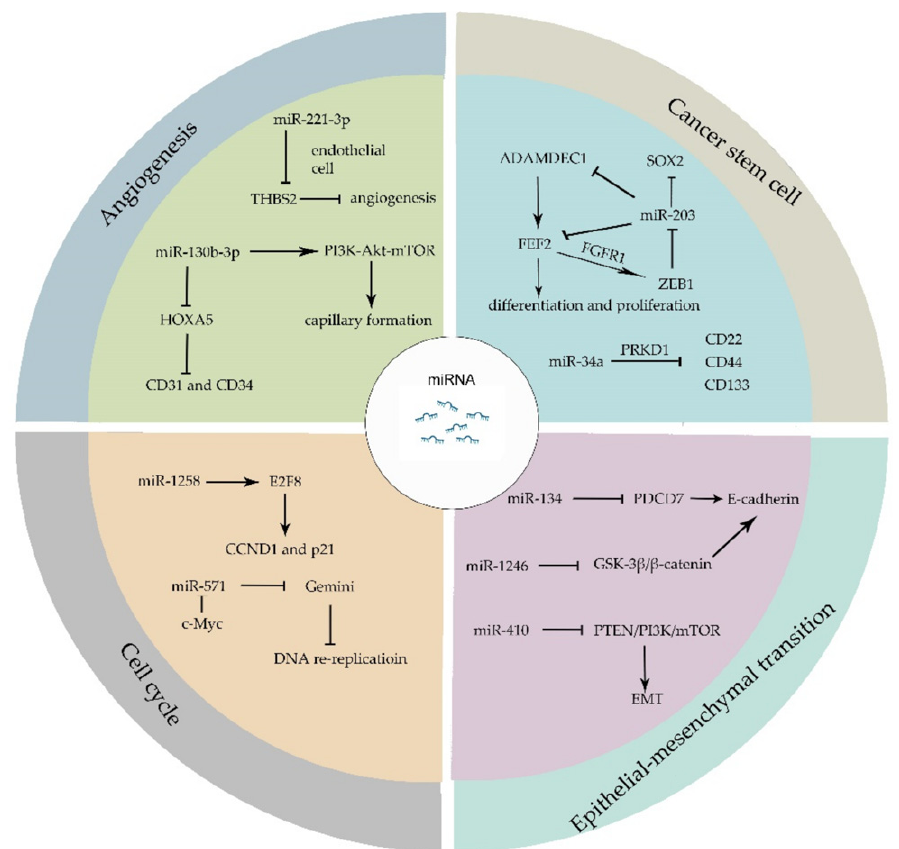
Figure 2. miRNAs modulate different hallmarks of cancer. miRNAs manipulate a set of biological processes that ultimately influences the proliferation and migration of cancer cells. ADAMDEC1, a disintegrin and metalloproteinase domain-like protein decysin 1; FEF2, Fibroblast growth factor 2; FGFR1, FGF receptor 1; ZEB1, Zinc-finger E-box-binding homeobox 1; PRKD1, serine/threonine- protein kinase D1; EMT, Epithelial–mesenchymal transition; PDCD7, Programmed Cell Death 7; CCND1, cyclin D1; p21, cyclin dependent kinase inhibitor 1A; THBS2,